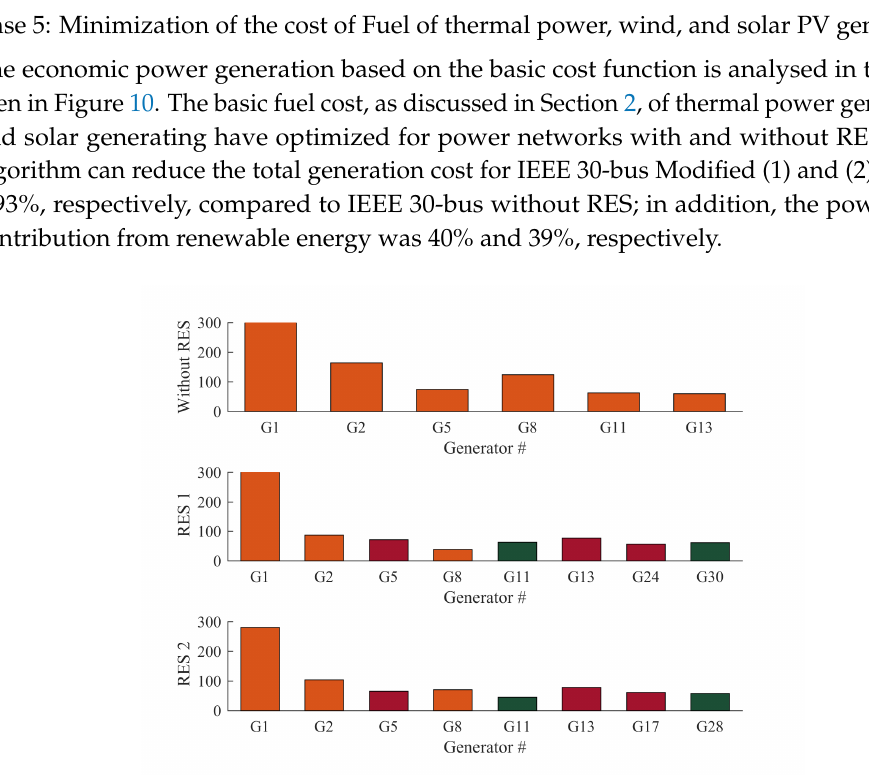
Figure 9. Voltage Stability Index (p.u.) for IEEE 30-bus system, IEEE 30-bus Modified (1) and IEEE 30-bus Modified (2).